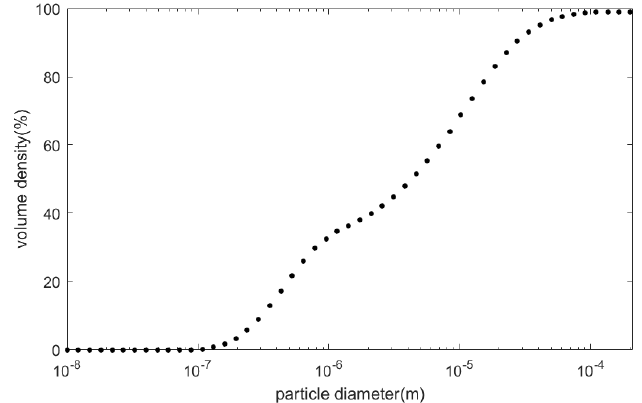
Figure 6. Cumulative curve of particle size distribution of the sediment sample collected at the Yellow River Garden Mouth.